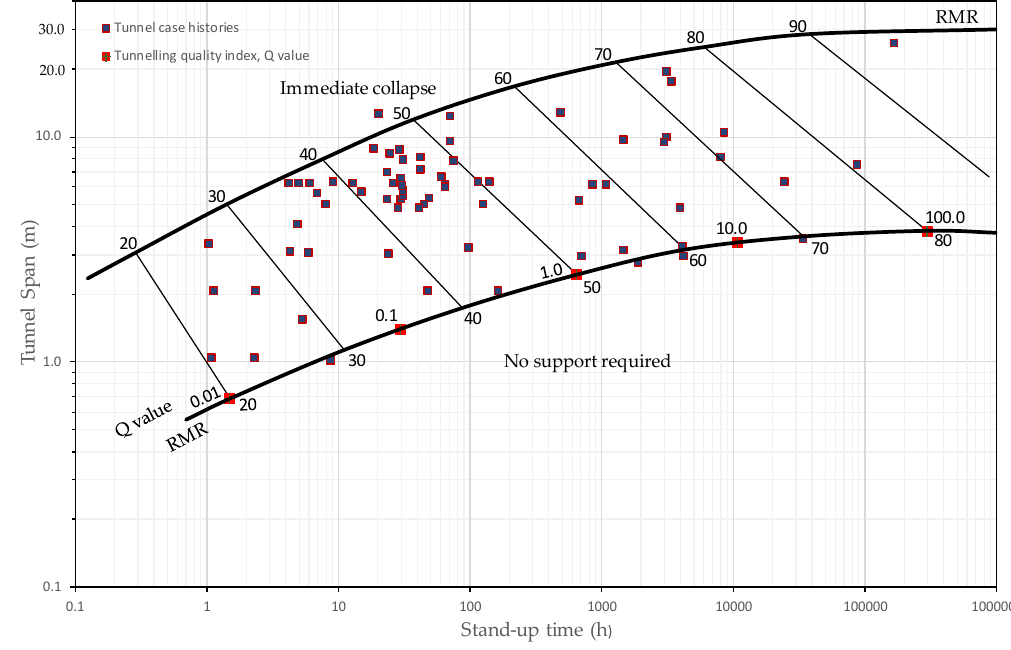
Figure 1. Stand-up time versus unsupported span of the tunnel for different RMR and Q values.